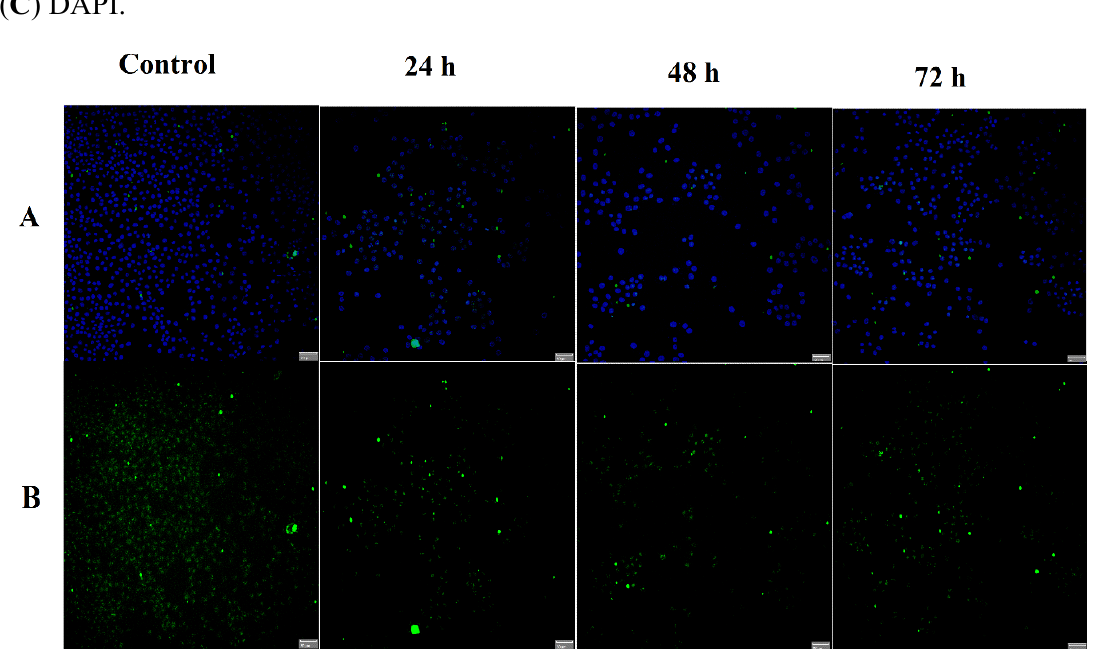
Figure 11. Immunofluorescent detection of Bcl-2 in MCF7 cells. The experiment was performed twice for this protein. Data revealed a decrease in the level of Bcl-2 protein after treatment. ( A ) Composite image of FITC with DAPI, ( B ) FITC conjugated with Bcl-2 and ( C )